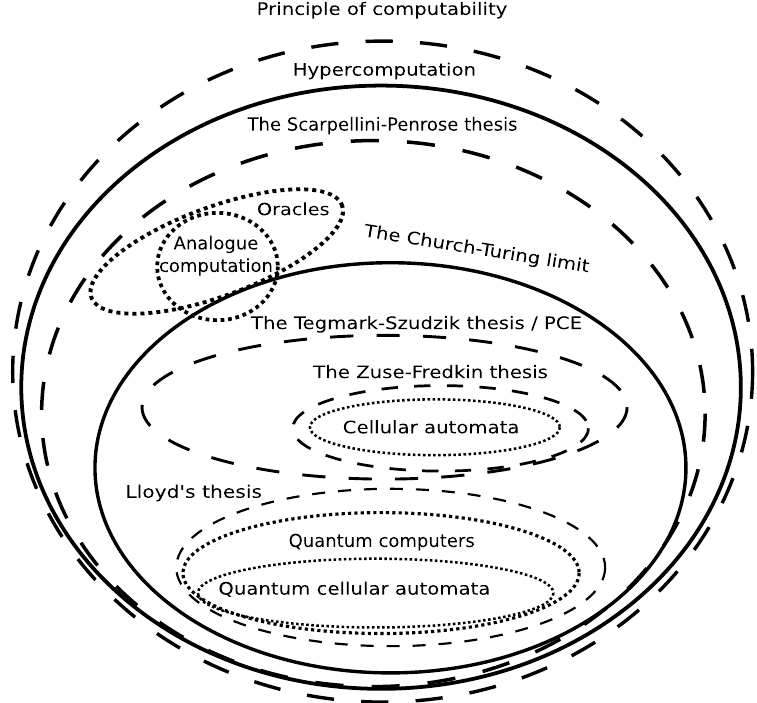
Figure 1. Graphical representation of the relationships between the different claims about the computational features of the universe and computational limits. The principle of computability hosts all the computational claims about the universe, but there are claims that are mutually